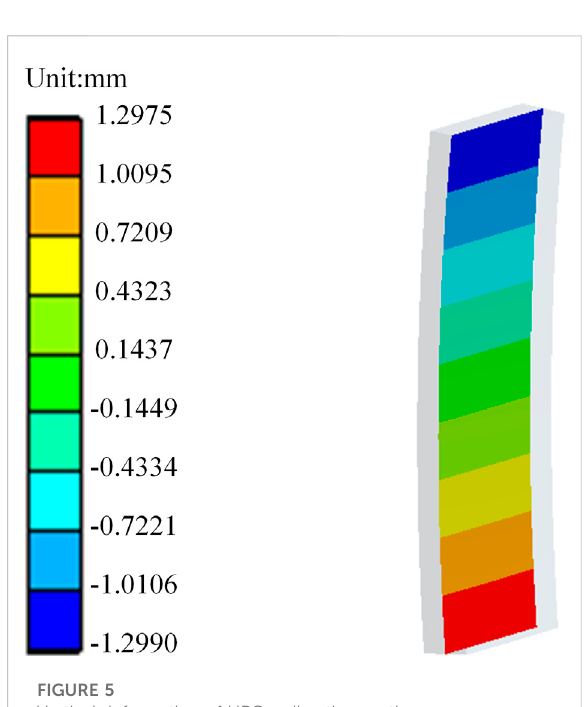
FIGURE 4 Overall frame deformation.